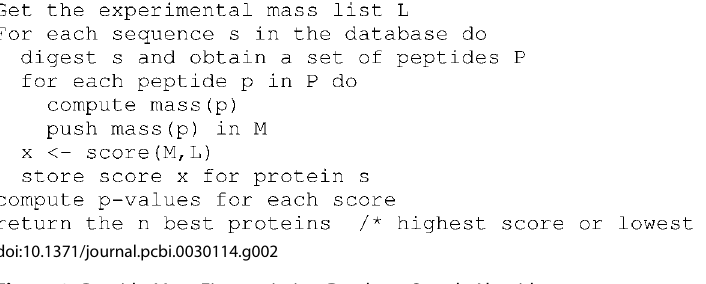
Figure 2. Peptide Mass Fingerprinting Database Search